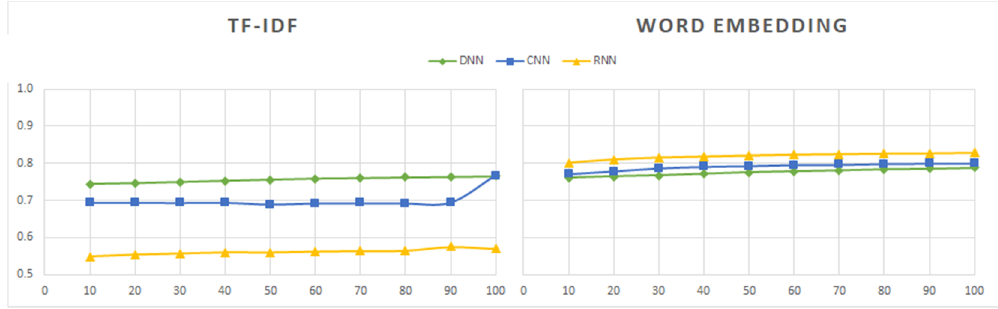
Figure 10. Accuracy values of deep-learning models with TF-IDF and word embedding for different numbers of tweets (percentage of the dataset).